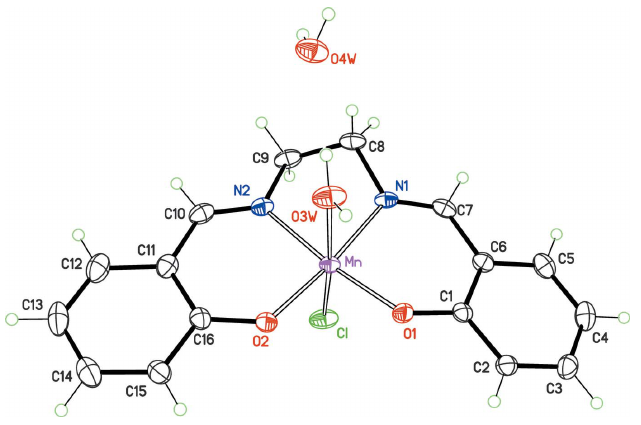
Figure 1 The structure of the title solvate, with displacement ellipsoids for non-H atoms at the 50% probability level.